Question: What does this figure show? Answer in one sentence.
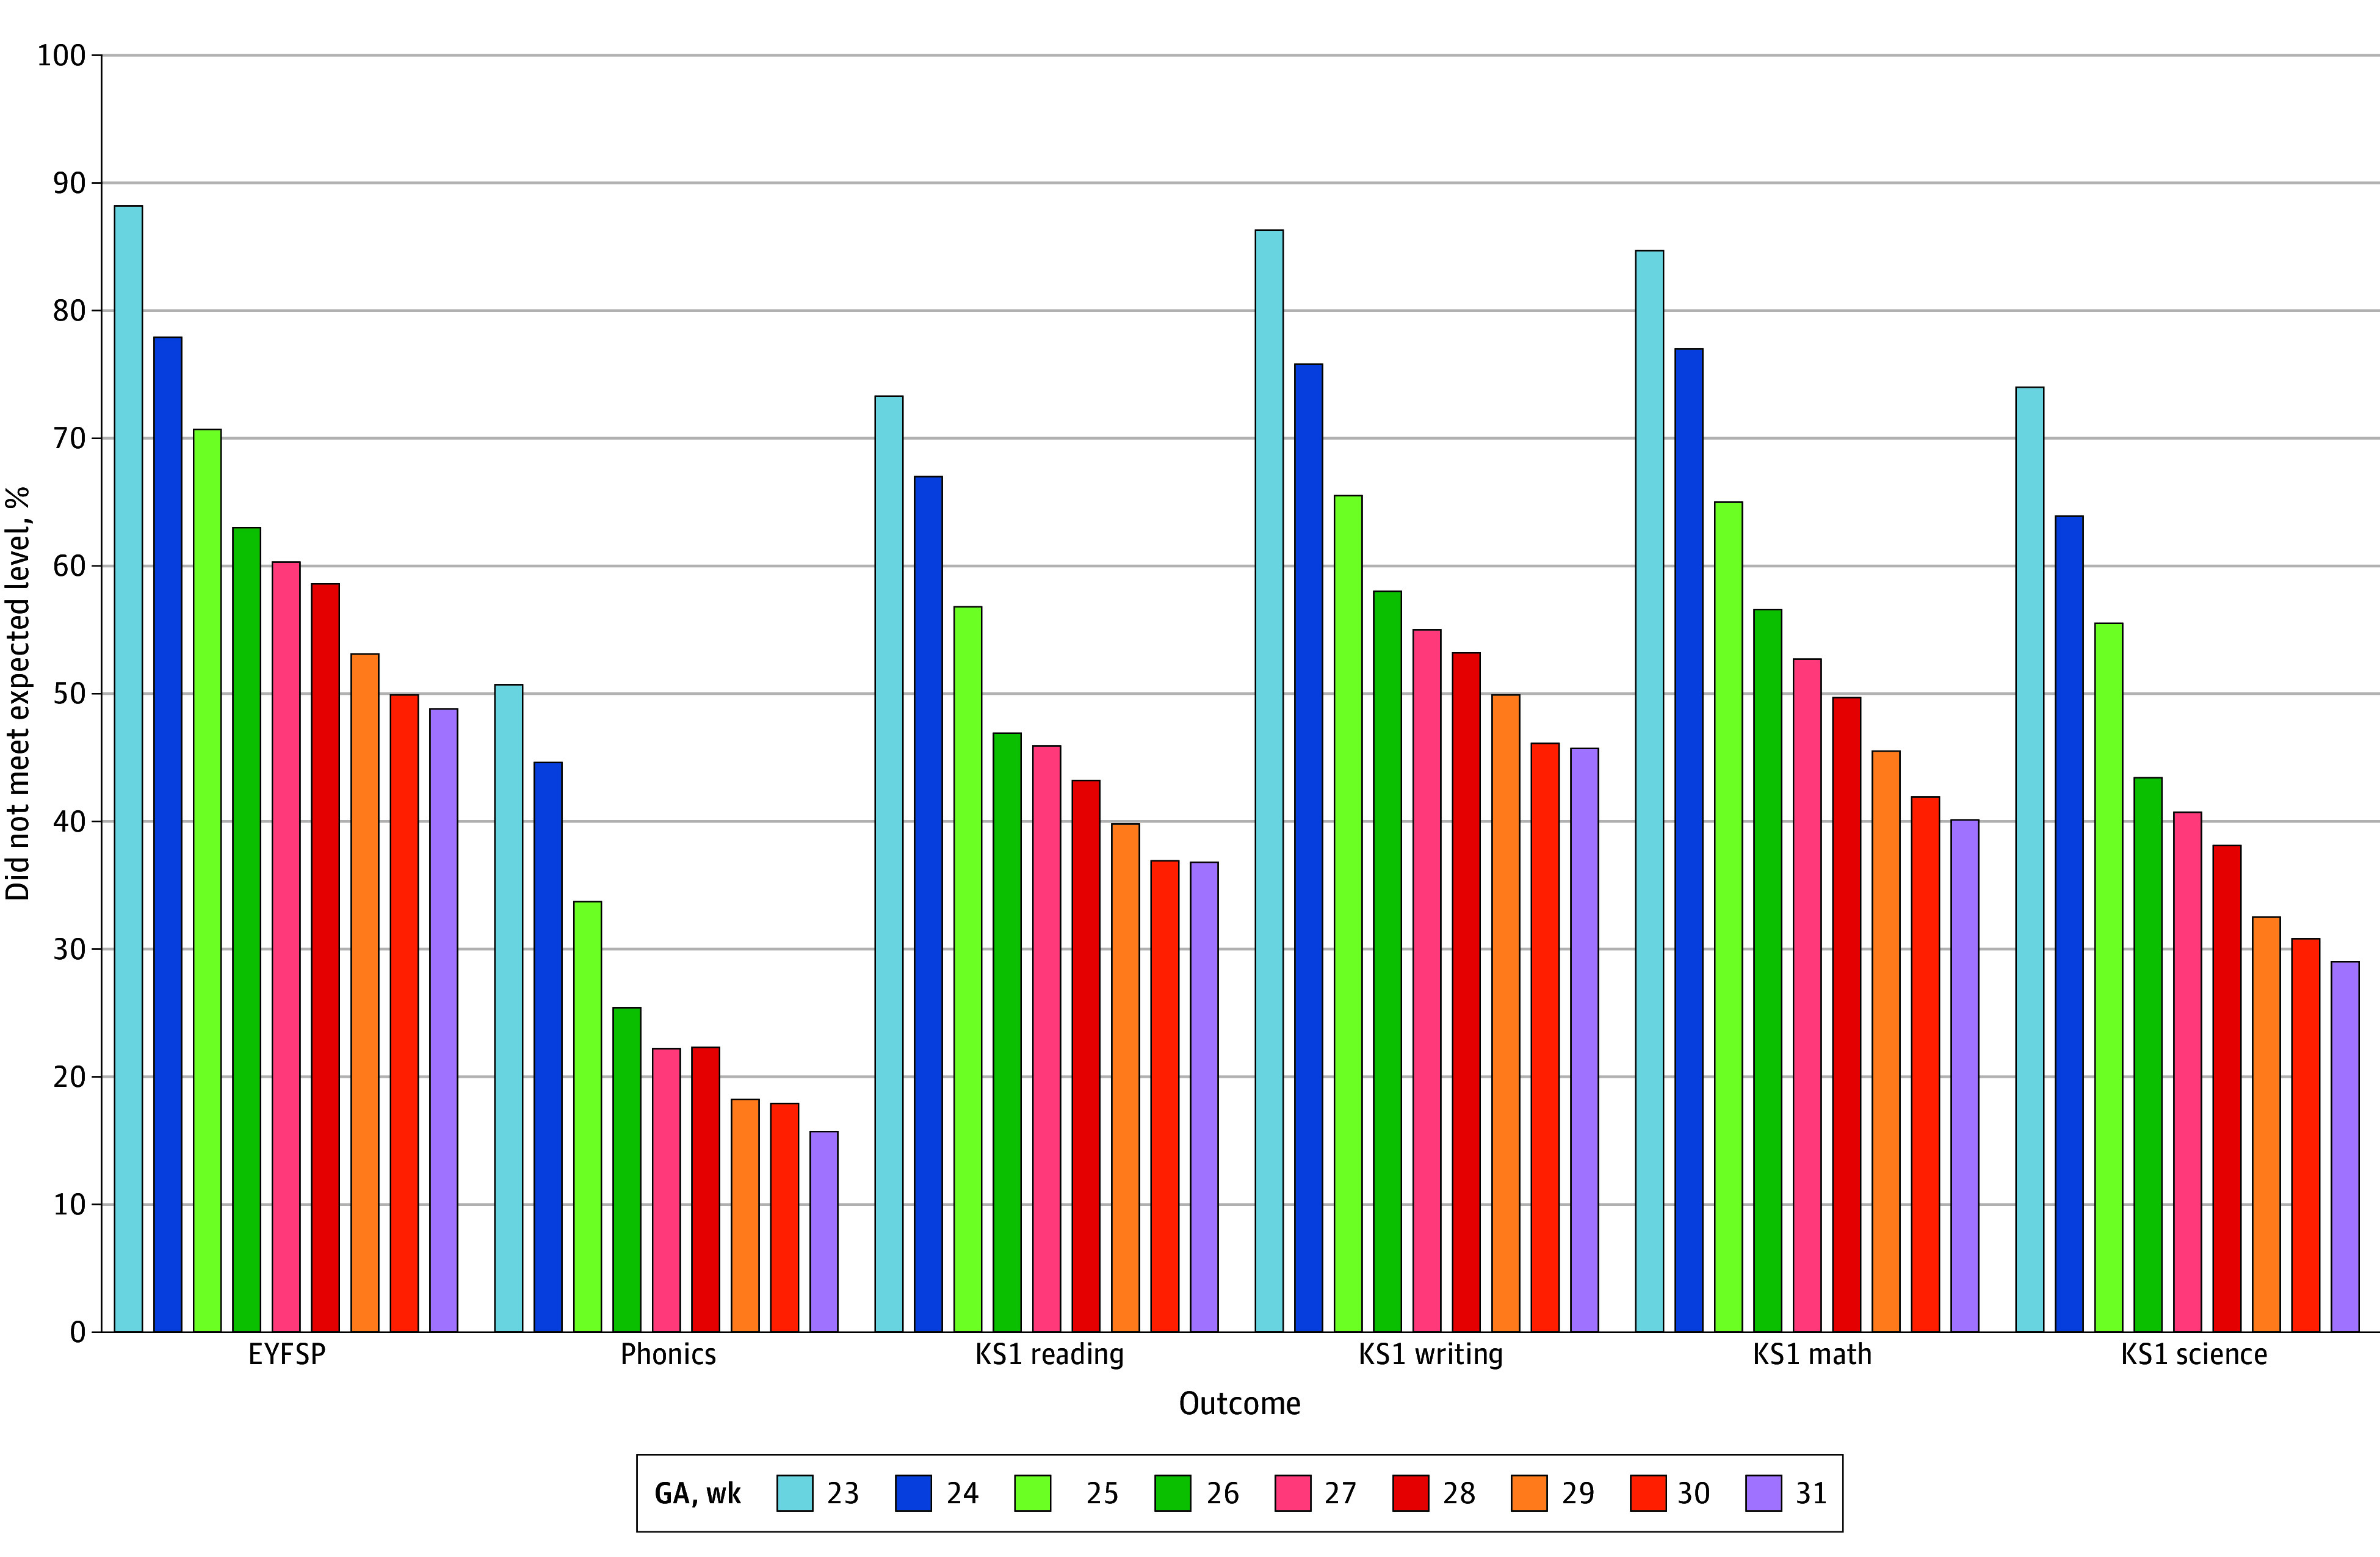
Answer: Bar Graph of the Distribution of Children Not Meeting Expected Levels by Outcome and Gestational Age (GA) Proportion in the overall cohort who did not meet expected level: Early Years Foundation Stage Profile (EYFSP), 8602 of 15 528 (55.9%); phonics, 3226 of 15 504 (20.8%); key stage 1 (KS1) reading, 6354 of 15 141 (42.0%); KS1 writing, 7789 of 15 141 (51.4%); KS1 math, 7216 of 15 140 (47.7%); KS1 science 5449 of 15 141 (36.0%).